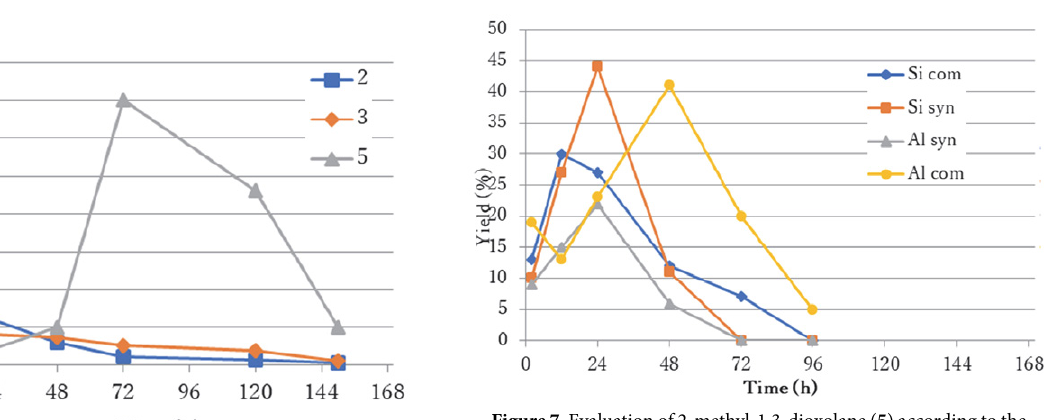
Figure 3. Evaluation of products 2 , 3 and 5 formed in the presence of commercial alumina Al com.